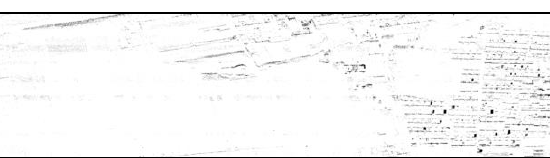
Figure 3. Automatic extracting result with Span method.